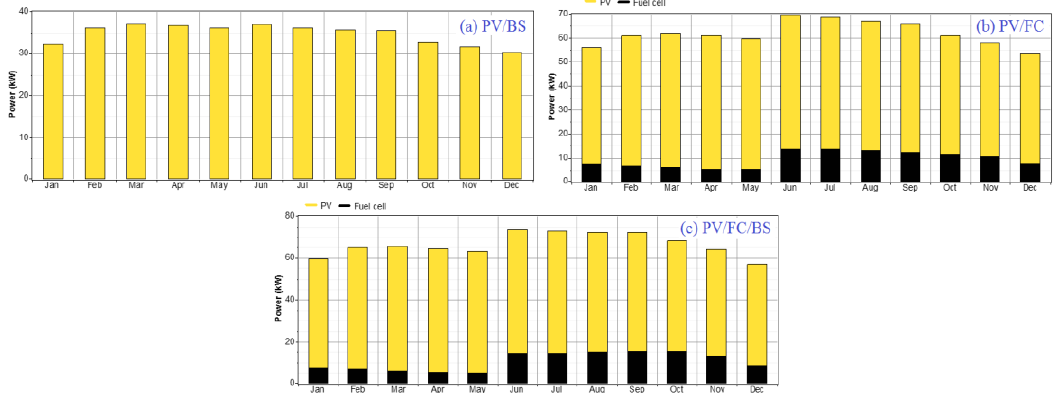
Figure 12. Average electric energy production.